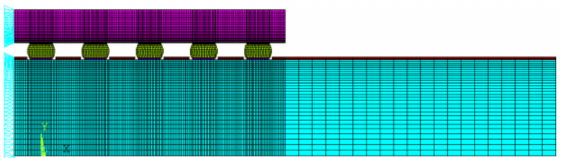
Figure 5. FEM model boundary condition.